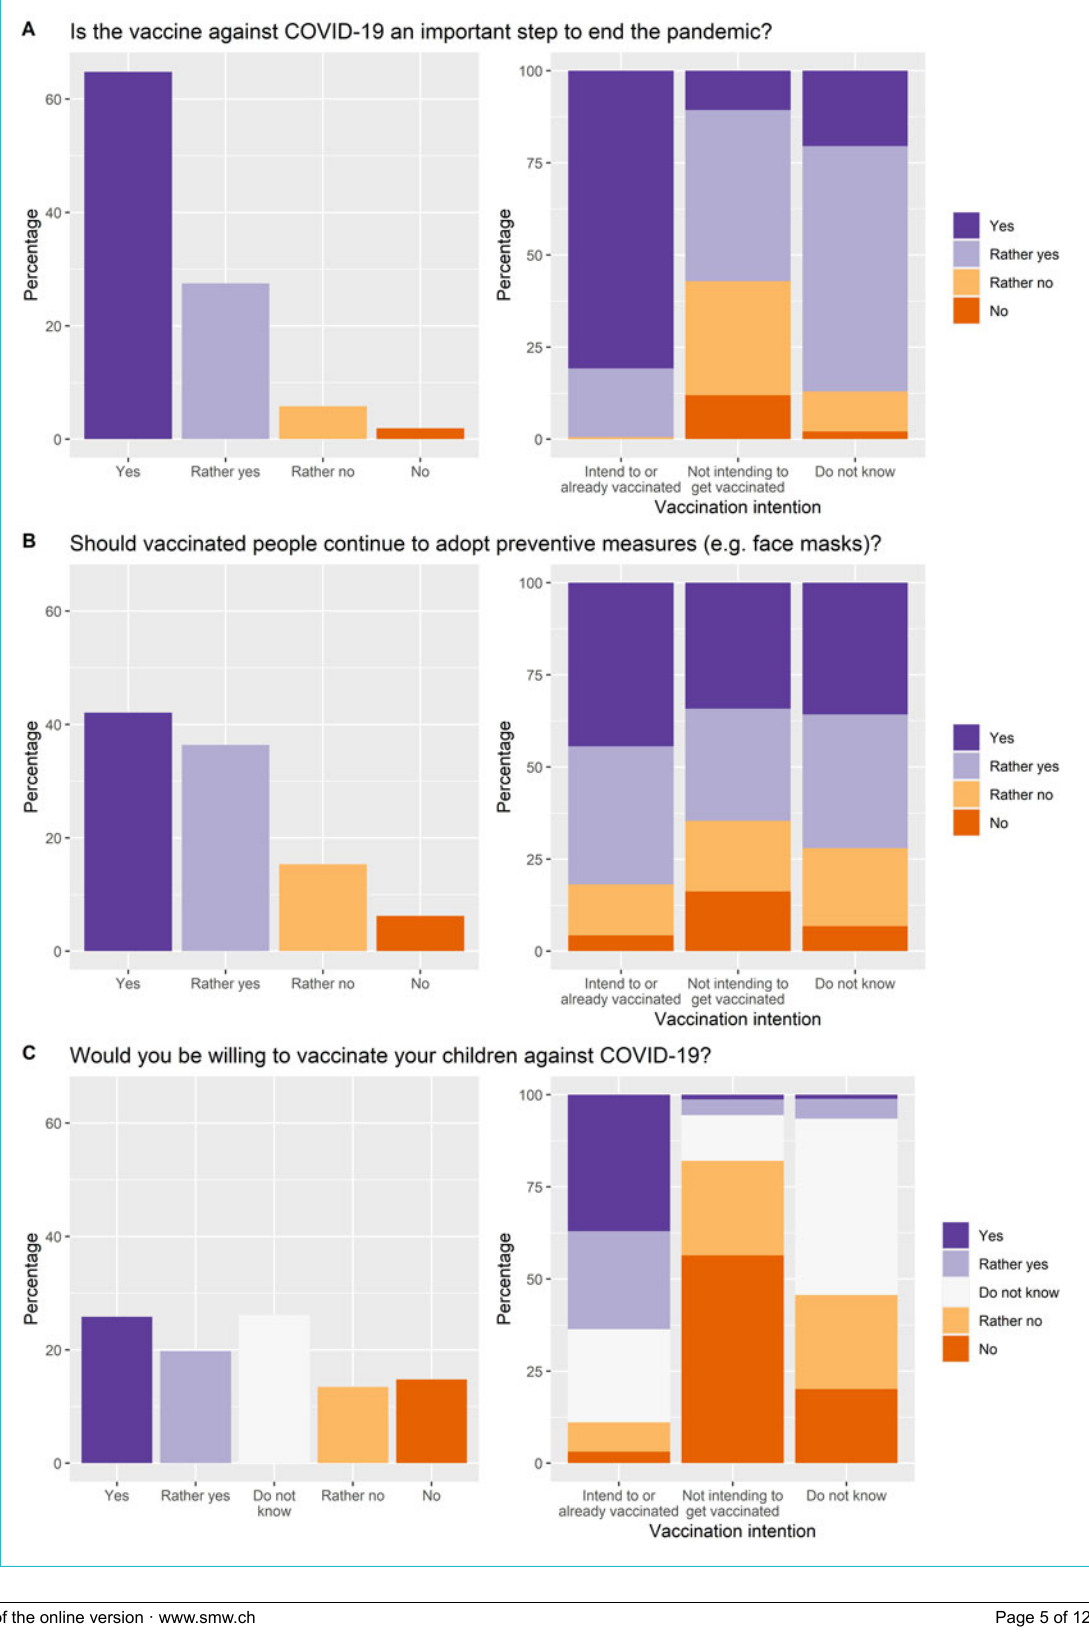
Figure 2: A. Proportion of participants agreeing that the COVID-19 vaccine is an important step to end the pandemic, in the overall sample (left) and stratified by vaccination intention (right). B. Proportion of participants agreeing that vaccinated individuals should continue to adopt preventive measures, in the overall sample (left) and stratified by vaccination intention (right). C. Proportion of participants willing to vaccinate their children, in the sample of participants with children under 18 years old (left) and stratified by vaccination intention